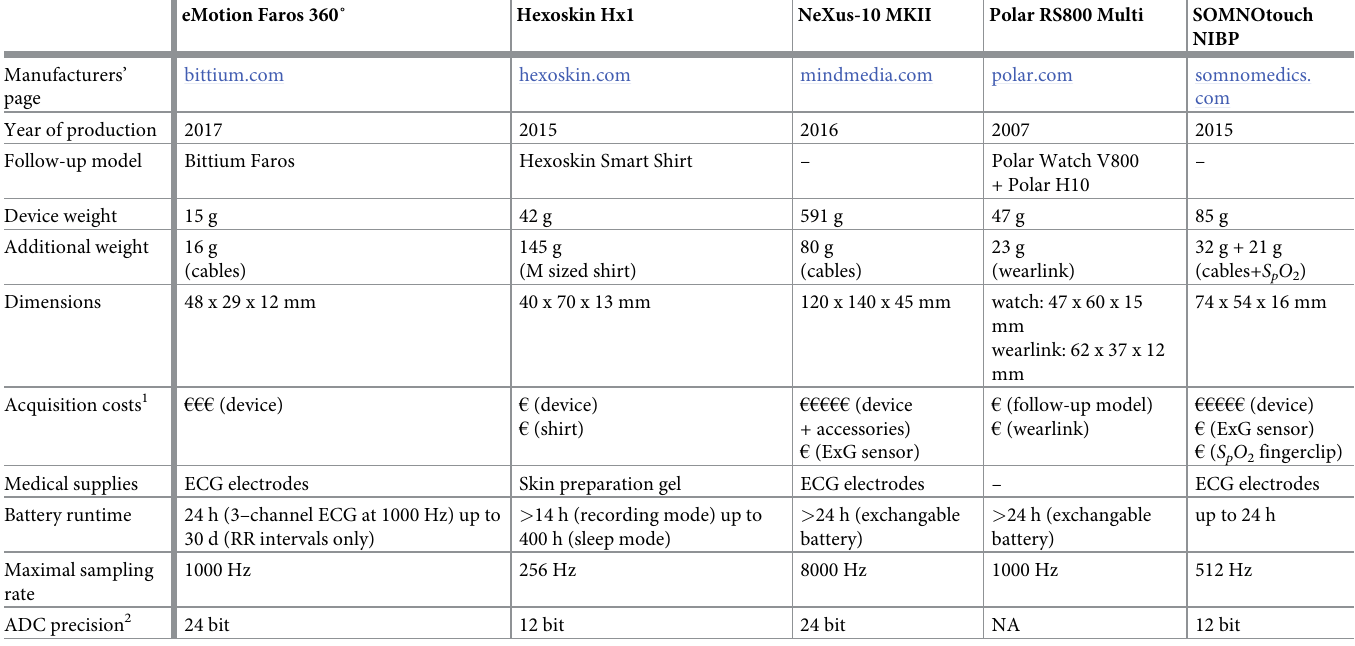
Table 1. General information about the measurement devices. See S1 Fig for the table with device images. eMotion Faros